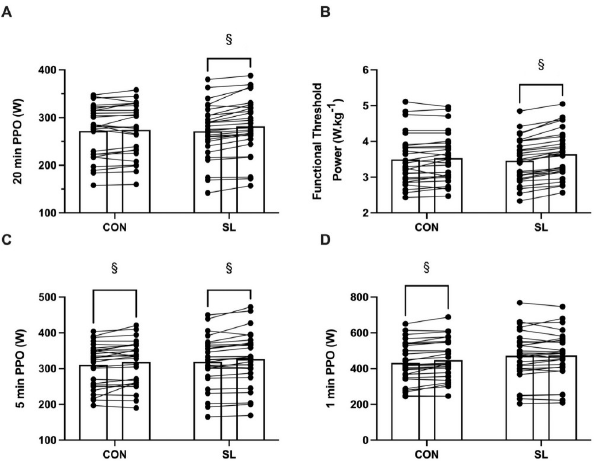
Fig 2. Mean power output recorded during the performance tests performed before (Pre) and after (Post) the intervention. A, Mean power output (W) during the 20-min PPO test; B, Mean functional threshold power (W � kg -1 ); C, Mean power output (W) during the 5-min PPO test; D, Mean power output (W) during the 1-min PPO test. Bars represent means for Sleep low (SL) and control (CON) groups with individual changes represented by connected dots. § denotes a significant difference between Pre and Post. P < 0.05 for all significant